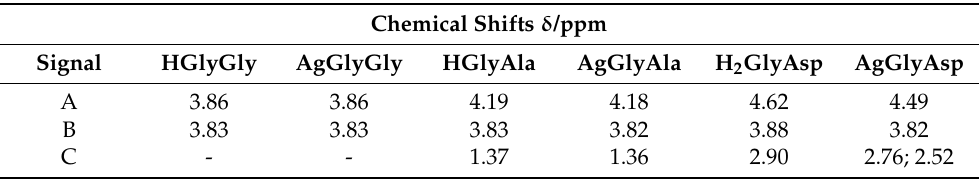
Table 2. 1 H NMR data of complexes AgGlyGly, AgGlyAla and AgGlyAsp and their appropriate ligands HGlyGly, HGlyAla and H 2 GlyAsp.